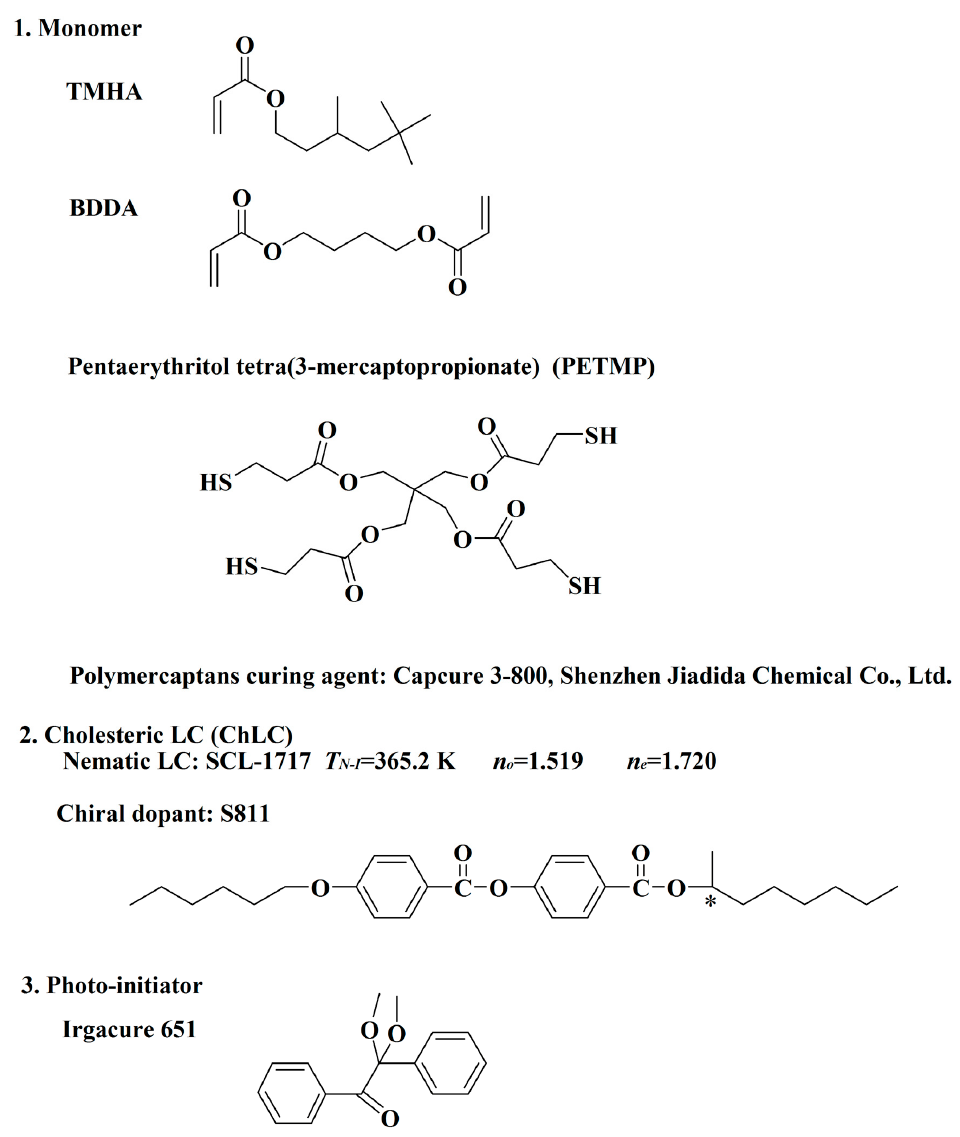
Figure 1. The chemical structures of the materials used. 1 is the monomer, 2 is the cholesteric LC, 3 is the photo-initiator.